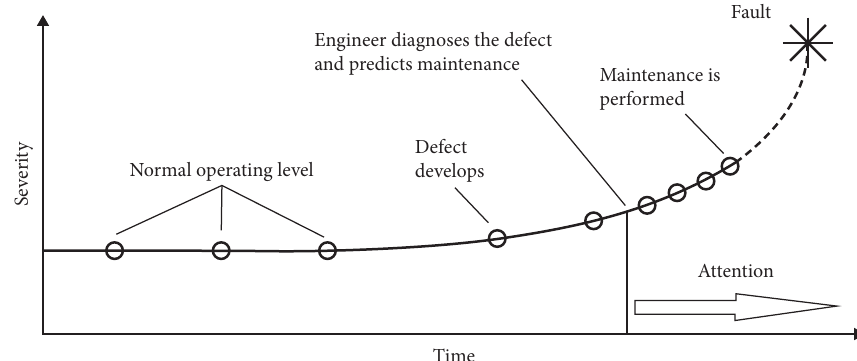
Figure 1: Stages of predictive maintenance (source: adapted from